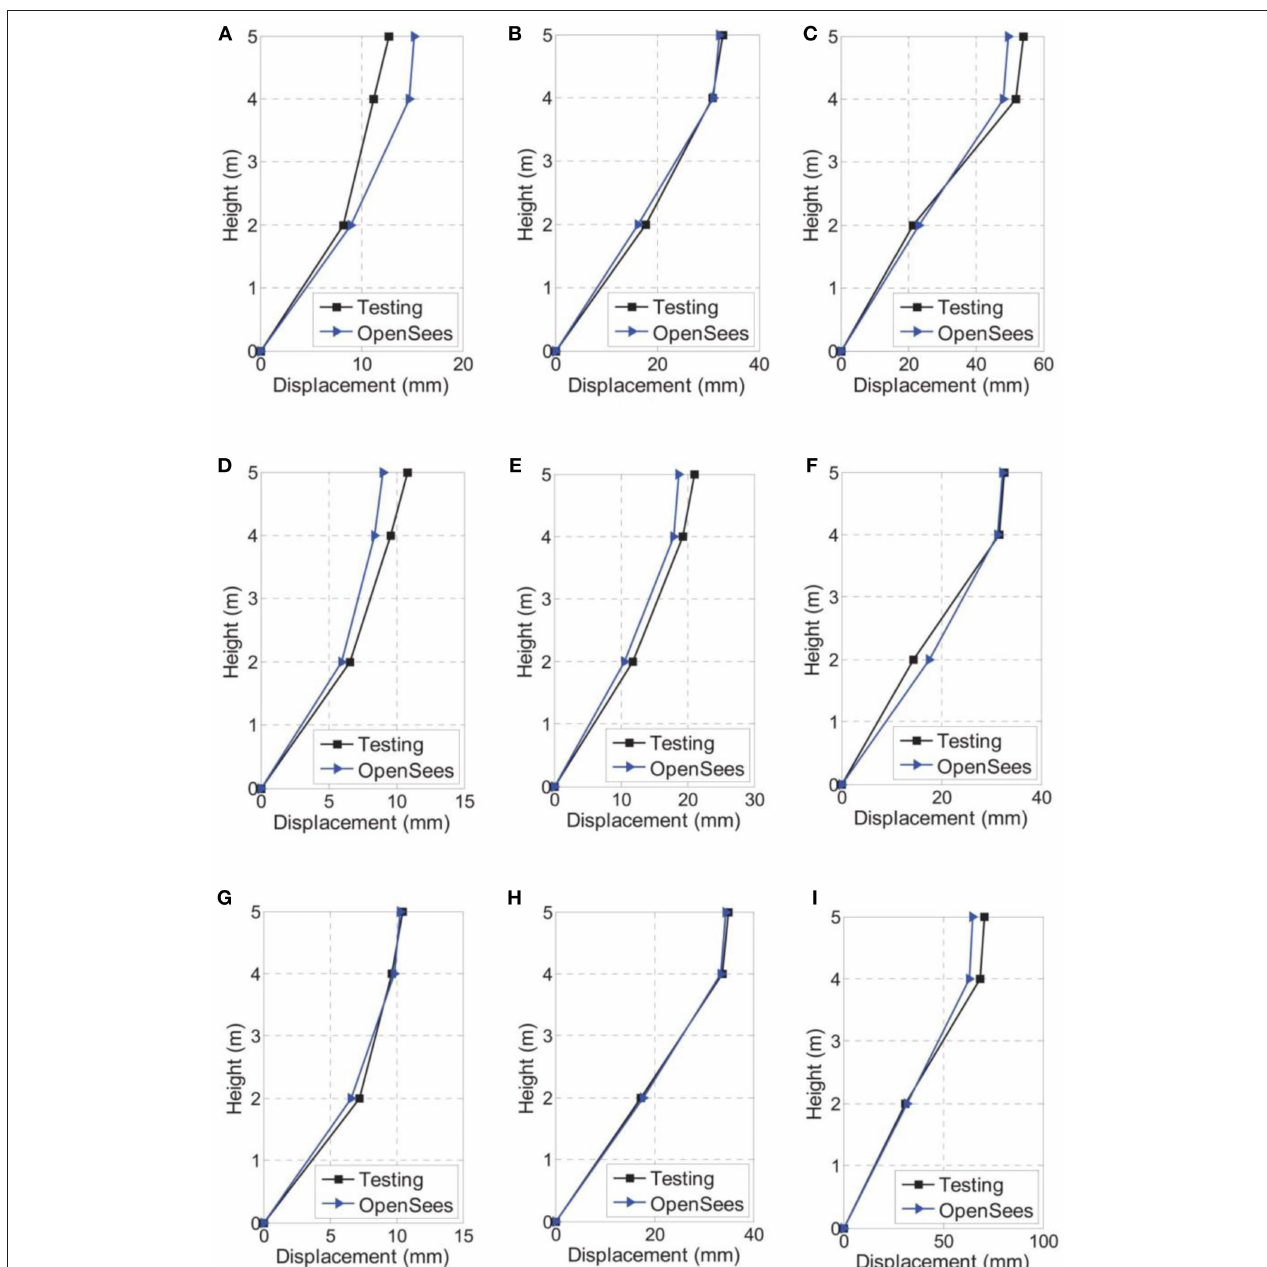
FIGURE 13 | Peak floor displacement response comparison under input of (A) El Centro-0.2g, (B) El Centro-0.4g, (C) El Centro-0.6g, (D) Taft-0.2g, (E) Taft-0.4g, (F) Taft-0.6g, (G) AW-0.2g, (H) AW-0.4g, and (I)